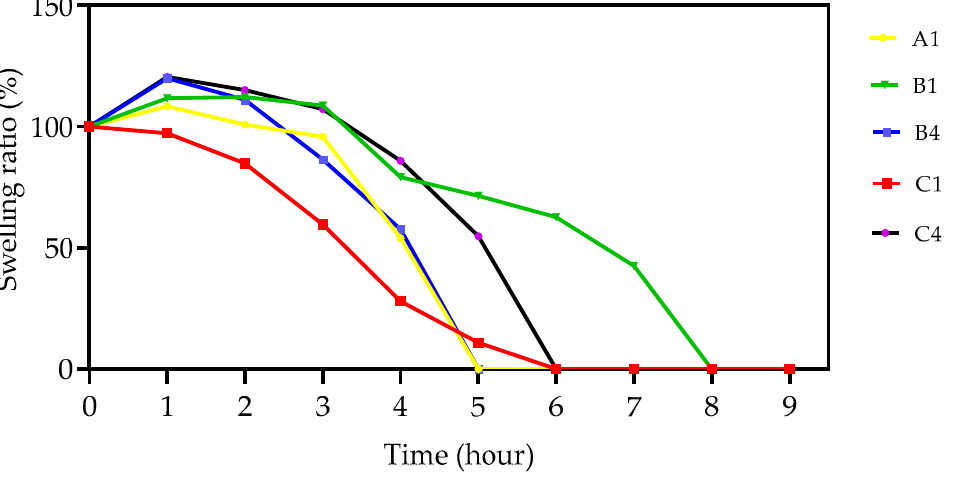
Figure 10. The swelling ratio of PNVCL, PNVCL/VAc, and PNVCL/NVP physically crosslinked samples were conducted at ambient temperature (~22 ◦ C). ( • ) PNVCL100, ( (cid:72) ) PNVCL90-VAc10, ( (cid:4) ) PNVCL60-VAc40, ( (cid:4) ) PNVCL90-NVP10, and ( • ) PNVCL60 ‐ NVP40.